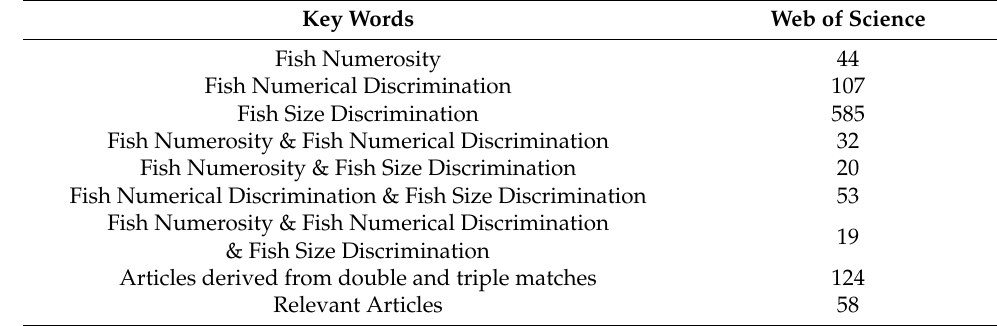
Table A1. Outcome of search strategy selection used in Web of Science (period covered between